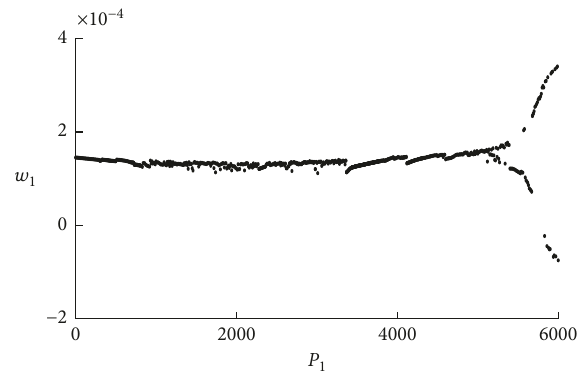
Figure 7: The bifurcation diagram of the system with change of P